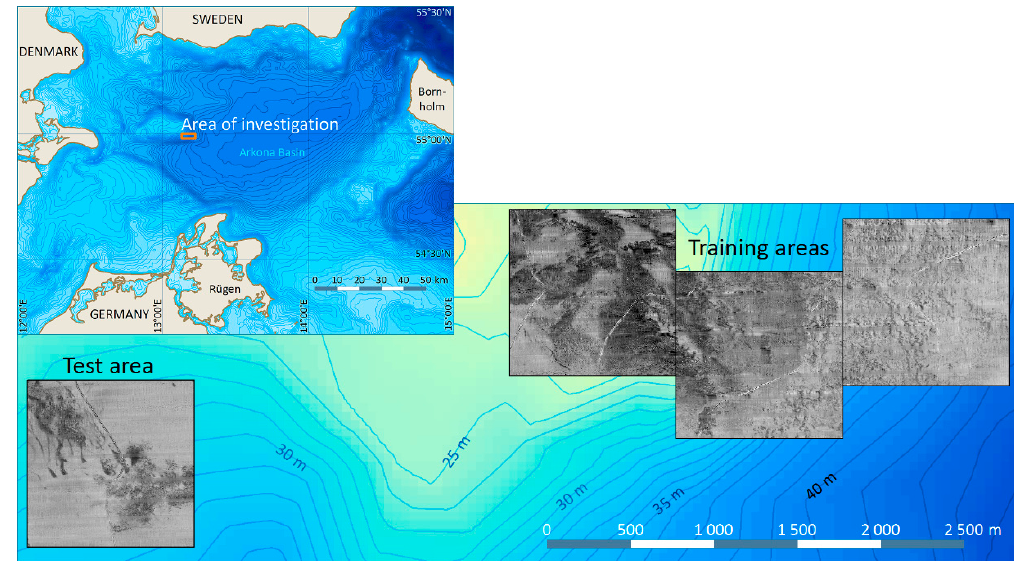
Figure 1. Location of the investigation area in the Baltic Sea and position of mosaics used for testing and training. Full resolution mosaics are available as Supplementary Material S2.